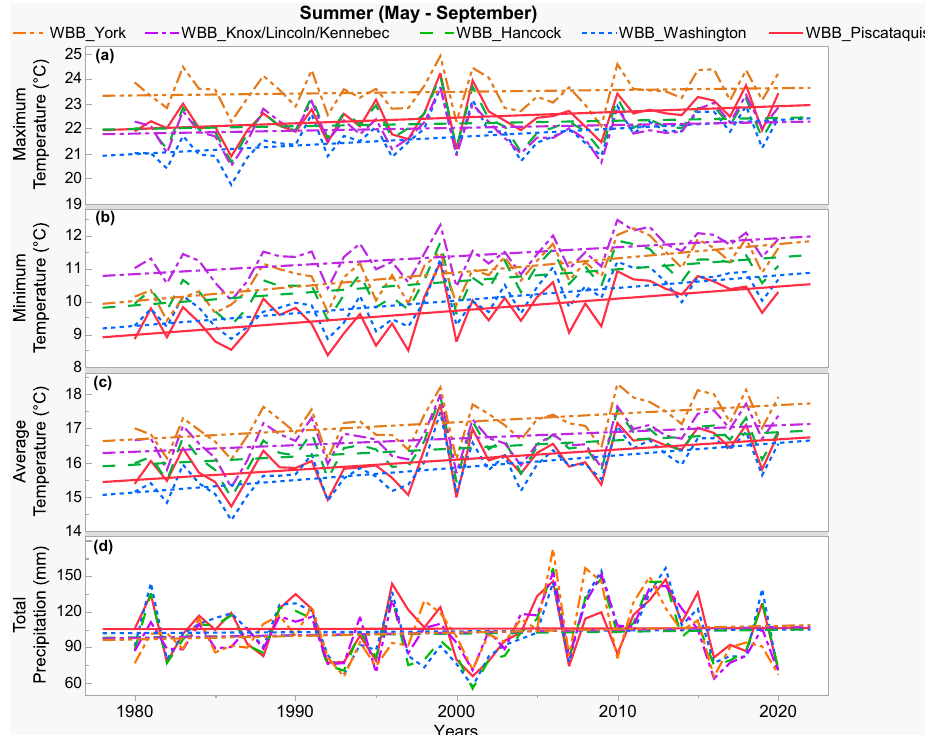
Figure 4. Comparison of historical (1980 to 2020) summer climate parameters: ( a ) maximum temperature, ( b ) minimum temperature, ( c ) average temperature, and ( d ) total precipitation among the studied wild blueberry barrens (WBBs) in different counties from north-central (Piscataquis) and north-east (Washington, Hancock) to south-west (Knox, Lincoln, Kennebec, York) of Maine as shown in Figure 1.